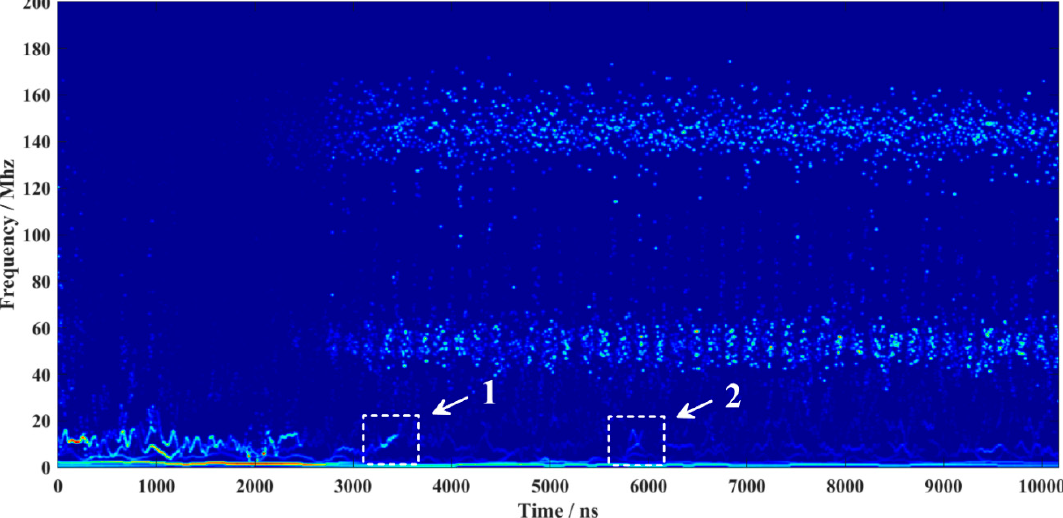
Figure 9. Hilbert spectrum of IMFs from N104.